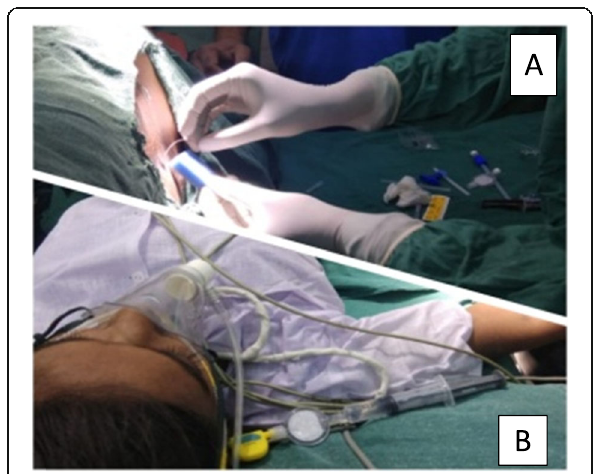
Fig. 1 a Insertion of epidural catheter in the left lateral position. b Syringe attached to the epidural catheter with filter for incremental dose in the supine